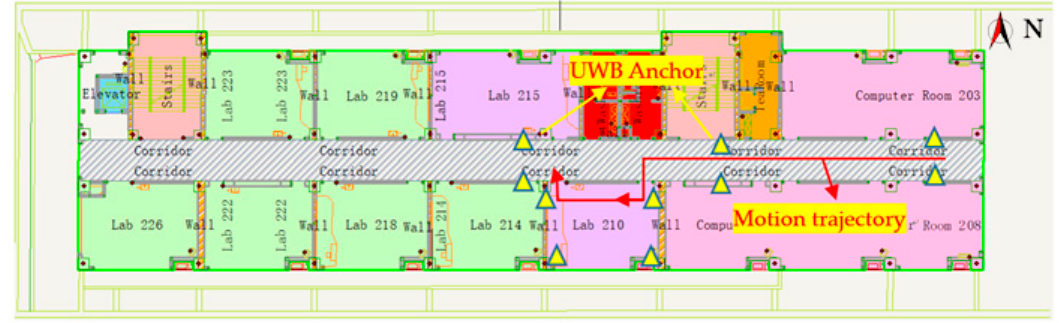
Figure 13. Schematic diagram of the location of the UWB base stations and rough walking route.